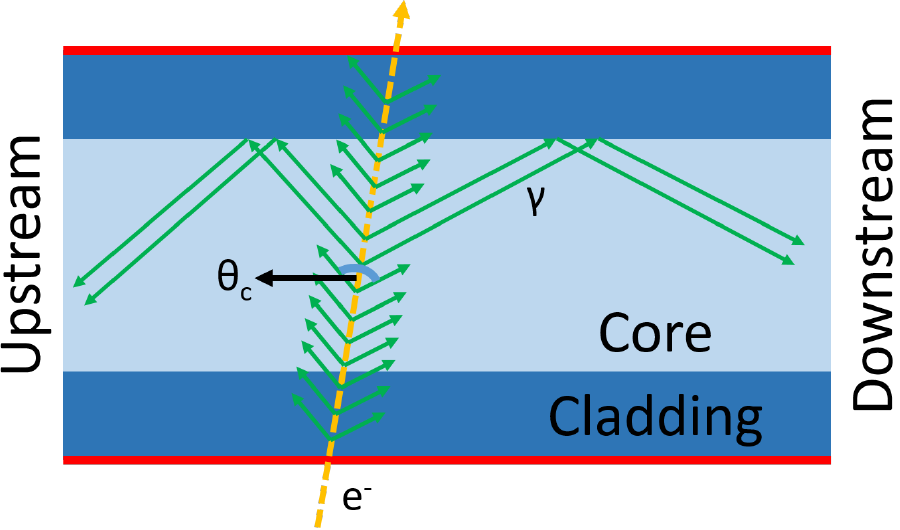
Figure 1. A simplified schematic of the generation, capture, and propagation of Cherenkov radiation in an optical